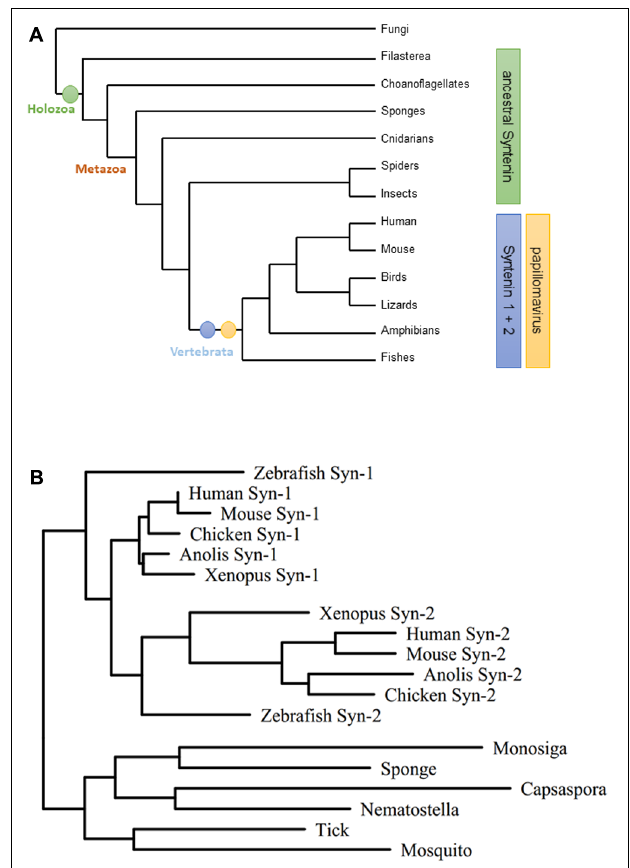
FIGURE 1 | Evolution of the Syntenin gene family. (A) Phylogram of major opisthokont lineages [tree simplified after (Torruella et al., 2015)]. Host range of papillomaviruses corresponds to Syntenin-1/Syntenin-2 evolutionary split. (B) Maximum likelihood tree for the Syntenin gene family. Representative Syntenin sequences were obtained from UniProt (The UniProt Consortium, 2017), aligned by the L-Ins-I algorithm of the MAFFT package (Katoh et al., 2002), and subjected to tree calculation by the T-Rex server (Boc et al., 2012) using the RAxML method (Stamatakis, 2006) (Syn-1: Syntenin-1; Syn-2: